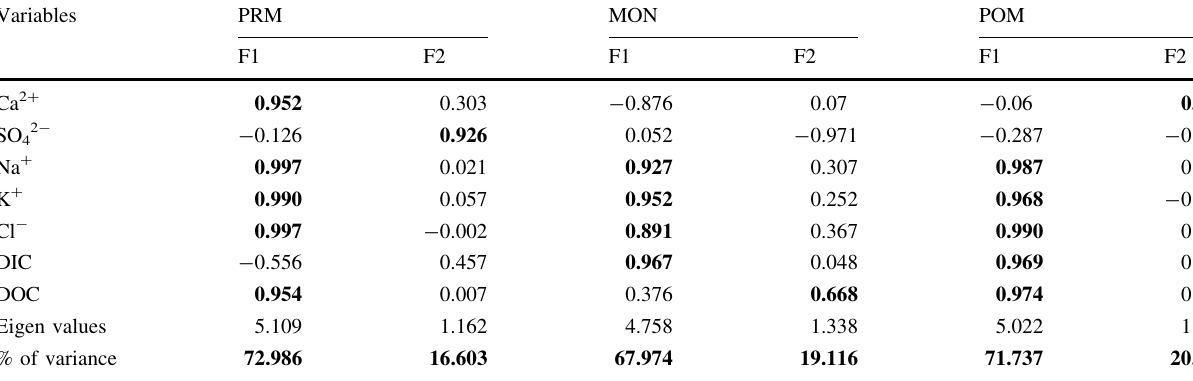
Table 3 Factor loading for PRM, MON and POM,